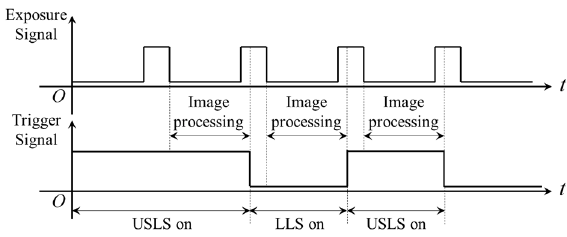
Figure 16. The correct method of generating the trigger signal.